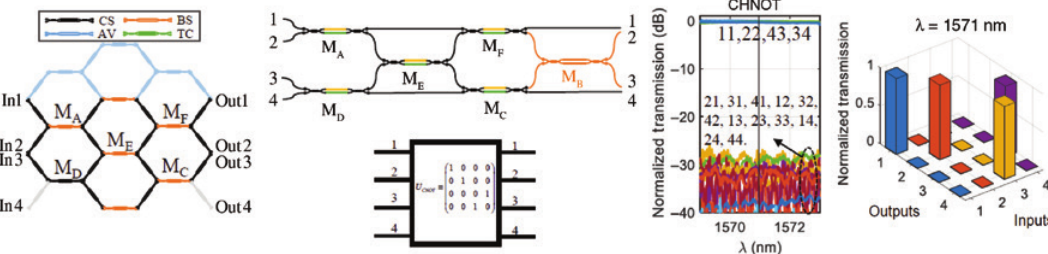
Figure 16: Programming and experimental results for a C-NOT transformation using the siicon waveguide mesh of Figure 9. (A) Configuration of a 4 × 4 interferometer based on a rectangular arrangement to implement a C-NOT transformation; left column: 7-cell configuration (CS = MZI in cross state, BS = MZI in bar state, TC = MZI in tunable coupler state, AV = MZI not employed); central-left column: circuit layout of the implemented interferometer; central-right column: spectral measurement of all input/output port connections. Right column: normalized bar diagram of the resulting unitary matrix for λ = 1571 nm (after Ref. [15]). Table 2: Circuit emulation capability of feedforward-only and feedforward/backward waveguide meshes. Feedforward-only waveguide meshes Feedforward/backward waveguide meshes Traditional FIR, IIR and FIR + IIR SISO and 2 × 2